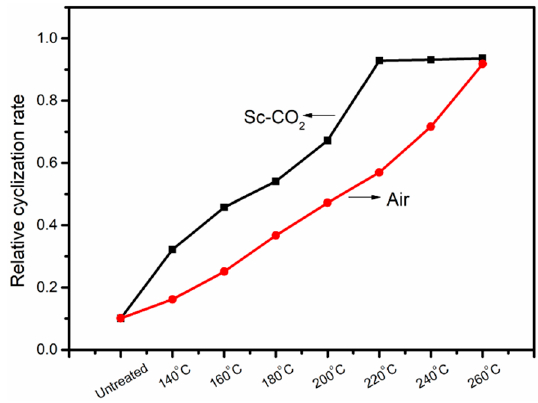
Figure 3. The relative cyclization rate (RCR) of PAN fibers calculated by FT-IR spectra.